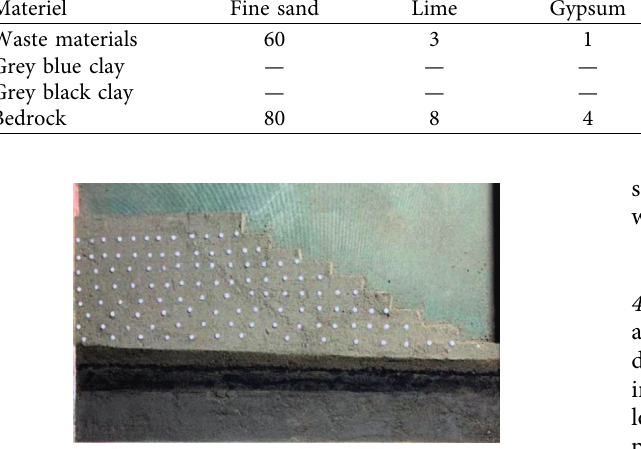
Figure 7: Initial